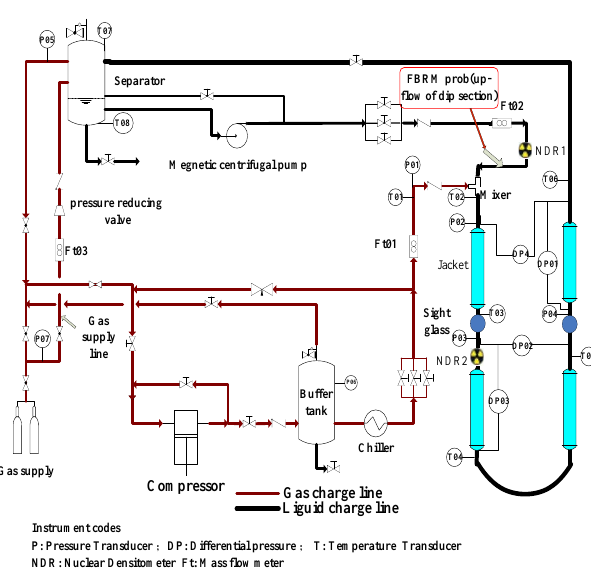
Figure 1. Schematic of the high-pressure hydrate flow loop.